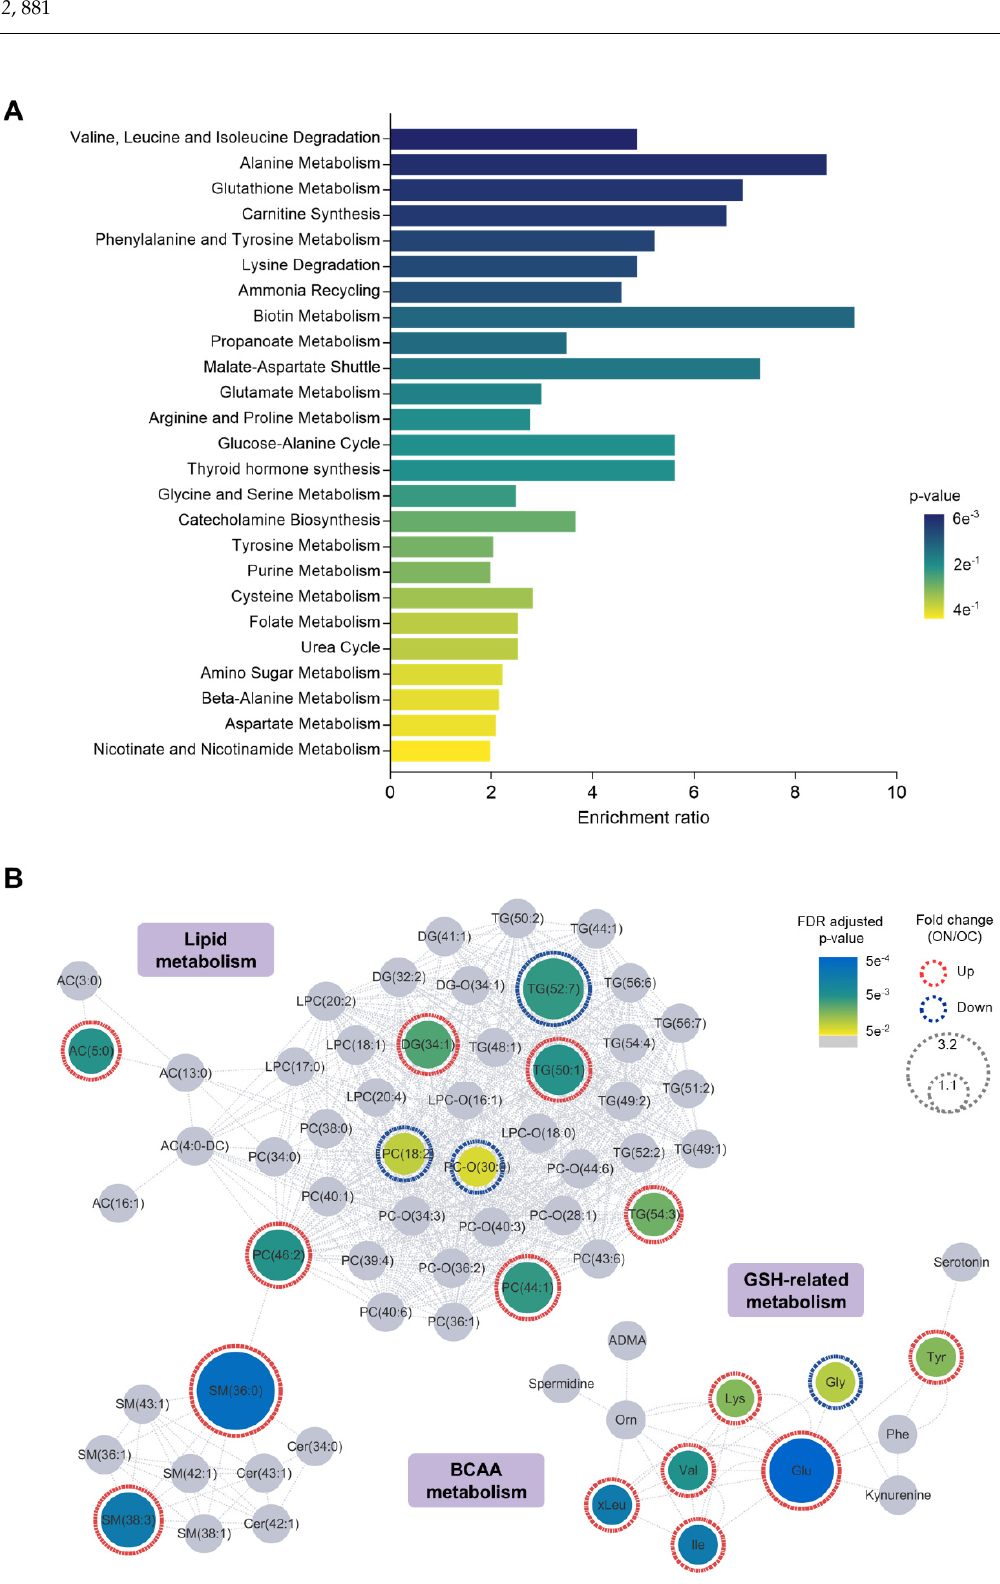
Figure 3. Relevance of NAFLD-specific metabolic features in metabolic pathways. ( A ) Enriched metabolite sets of NAFLD-specific metabolic features and ( B ) biochemical and chemical networks of the selected significant metabolites indicated the pertinent metabolic pathways in NAFLD status, such as branched-chain amino acid (BCAA), glutathione (GSH)-related, and lipid metabolism. In the network, the gray nodes indicate metabolites with raw p -values < 0.05 that were not significant after FDR adjustment. Abbreviations: NAFLD, nonalcoholic fatty liver disease; and FDR, false discovery rate.